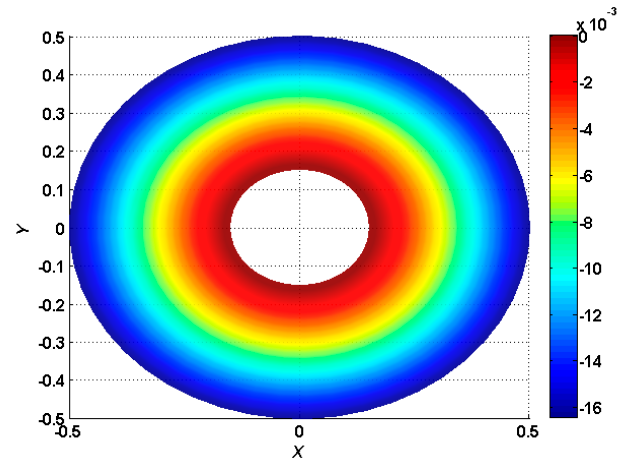
with torus 0.3 h R = and internal w wE h q = Al ,